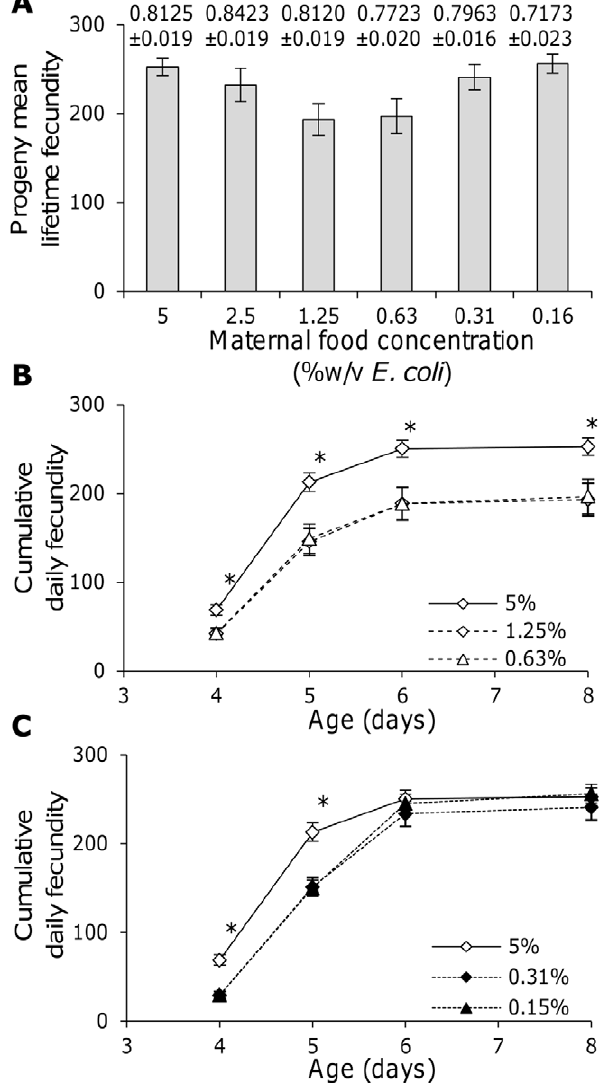
Figure 1. Maternal food availability affects progeny reproduc- tion. Lifetime fecundity (A) and mean cumulative daily fecundity (B and C) on ad libitum food of the progeny of worms from different maternal food availabilities. Error bars are 6 1 standard error and the mean ( 6 1 standard error) maternal length for each food availability is noted above the corresponding bar in A. * Indicates that the cumulative progeny fecundity on that day differs significantly between parental food availabilities (Kruskal-Wallis, p , 0.05). Mean fecundities were calculated from at least 21 hermaphrodites (range 21–28, median of 26).